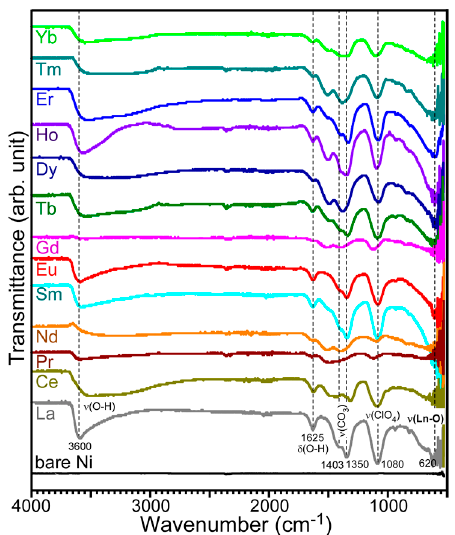
Figure 4. Transmittance FT-IR spectra for electrodeposited RE elements over a Ni sheet.